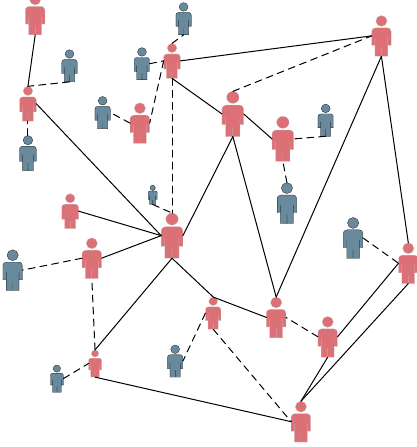
Figure 5. User affiliation network.